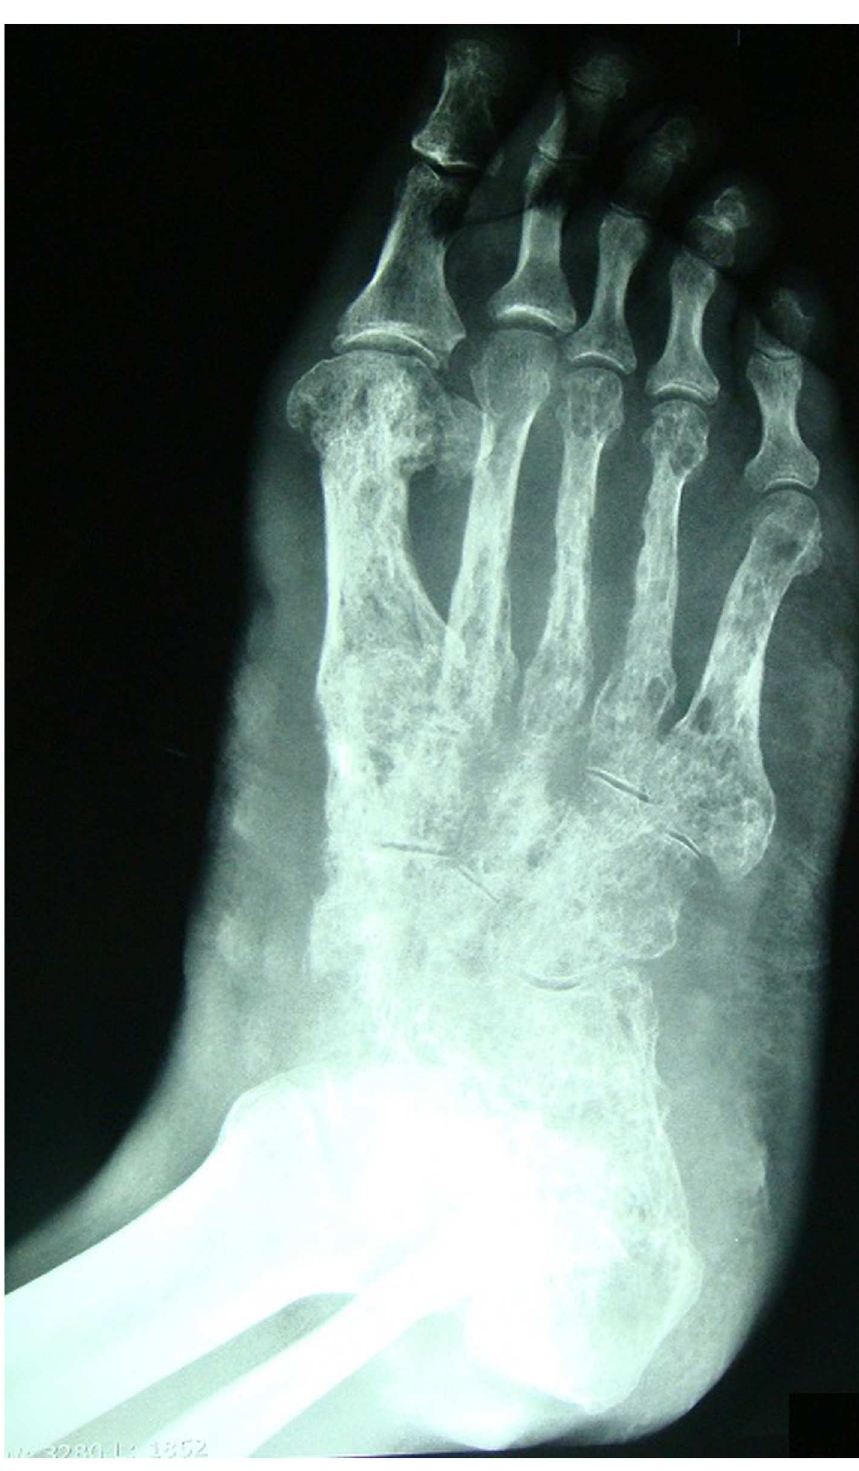
Fig 6. Radiography showing bone destruction.